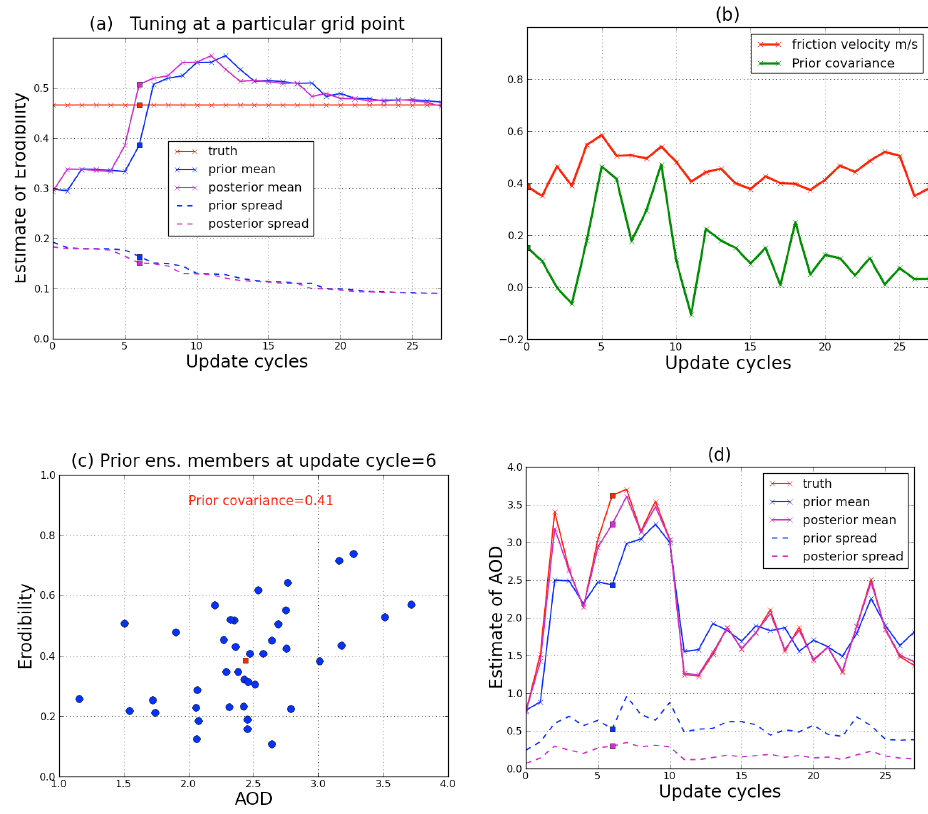
Fig. 2. Tuning of at a particular grid point marked K in Fig. 1a. The estimates of various quantities at this grid point are shown. See Sect. 3.2 for discussion. (a) Estimates of α (means and spreads). (b) The time series of covariance between α and AOD is shown in green. (c) The Figure 2 : Tuning of α at a particular grid point marked K in Figure 1a. The prior ensemble members at update cycle 6. This update cycle is marked with squares in (a) , (b) and (d) . The red square shows the mean of estimates of various quantities at this grid point are shown. See section 3(ii) the ensemble. (d) Estimates of AOD (means and for discussion.